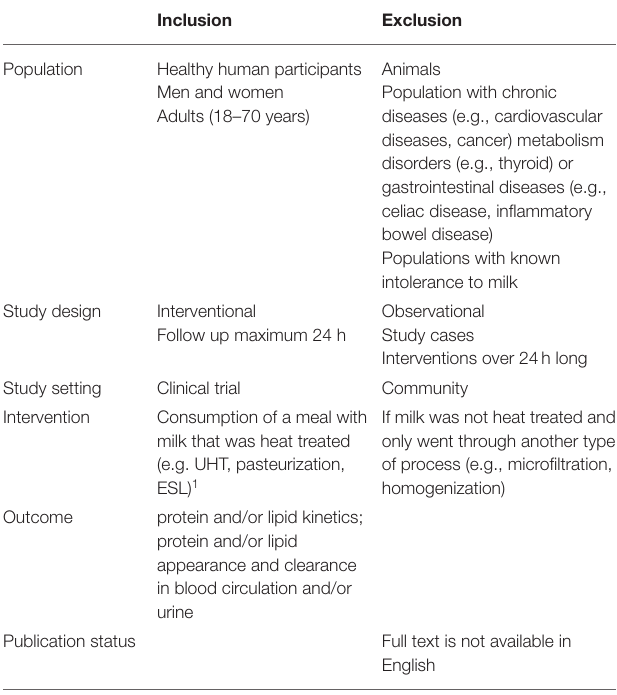
TABLE 2 | Inclusion and exclusion criteria applied in article